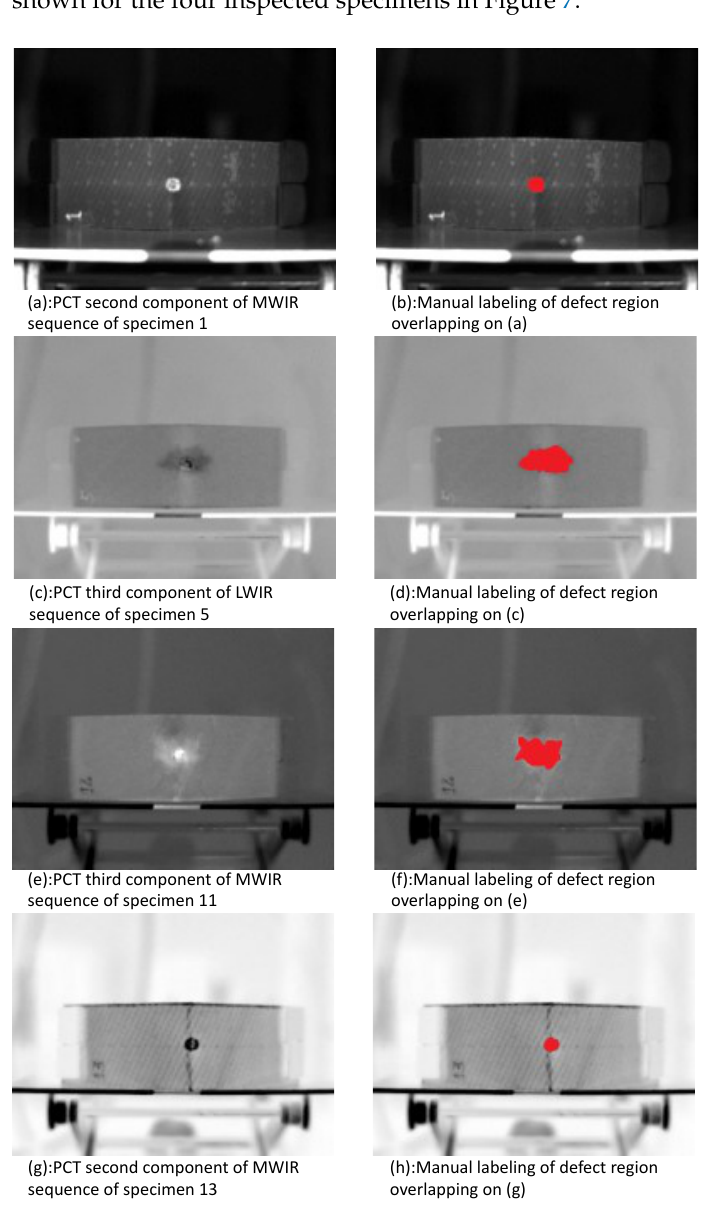
Figure 7. PCT results of impacted specimen and corresponding